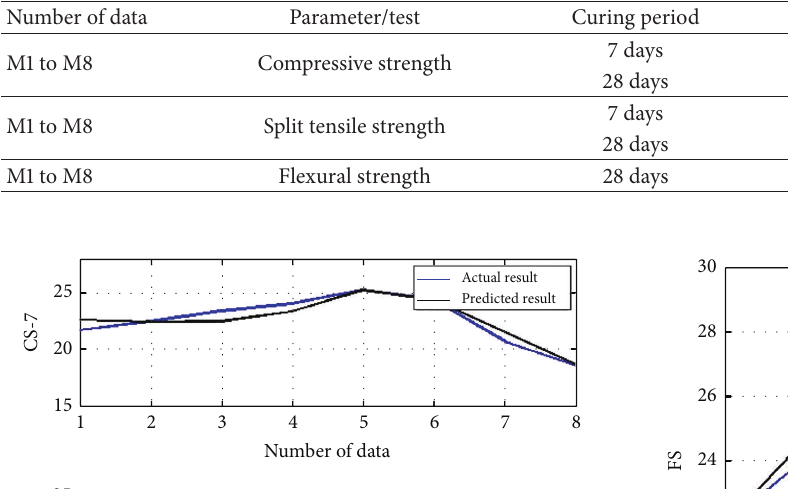
Table 5: Comparison of actual and predicted results for various parameters.